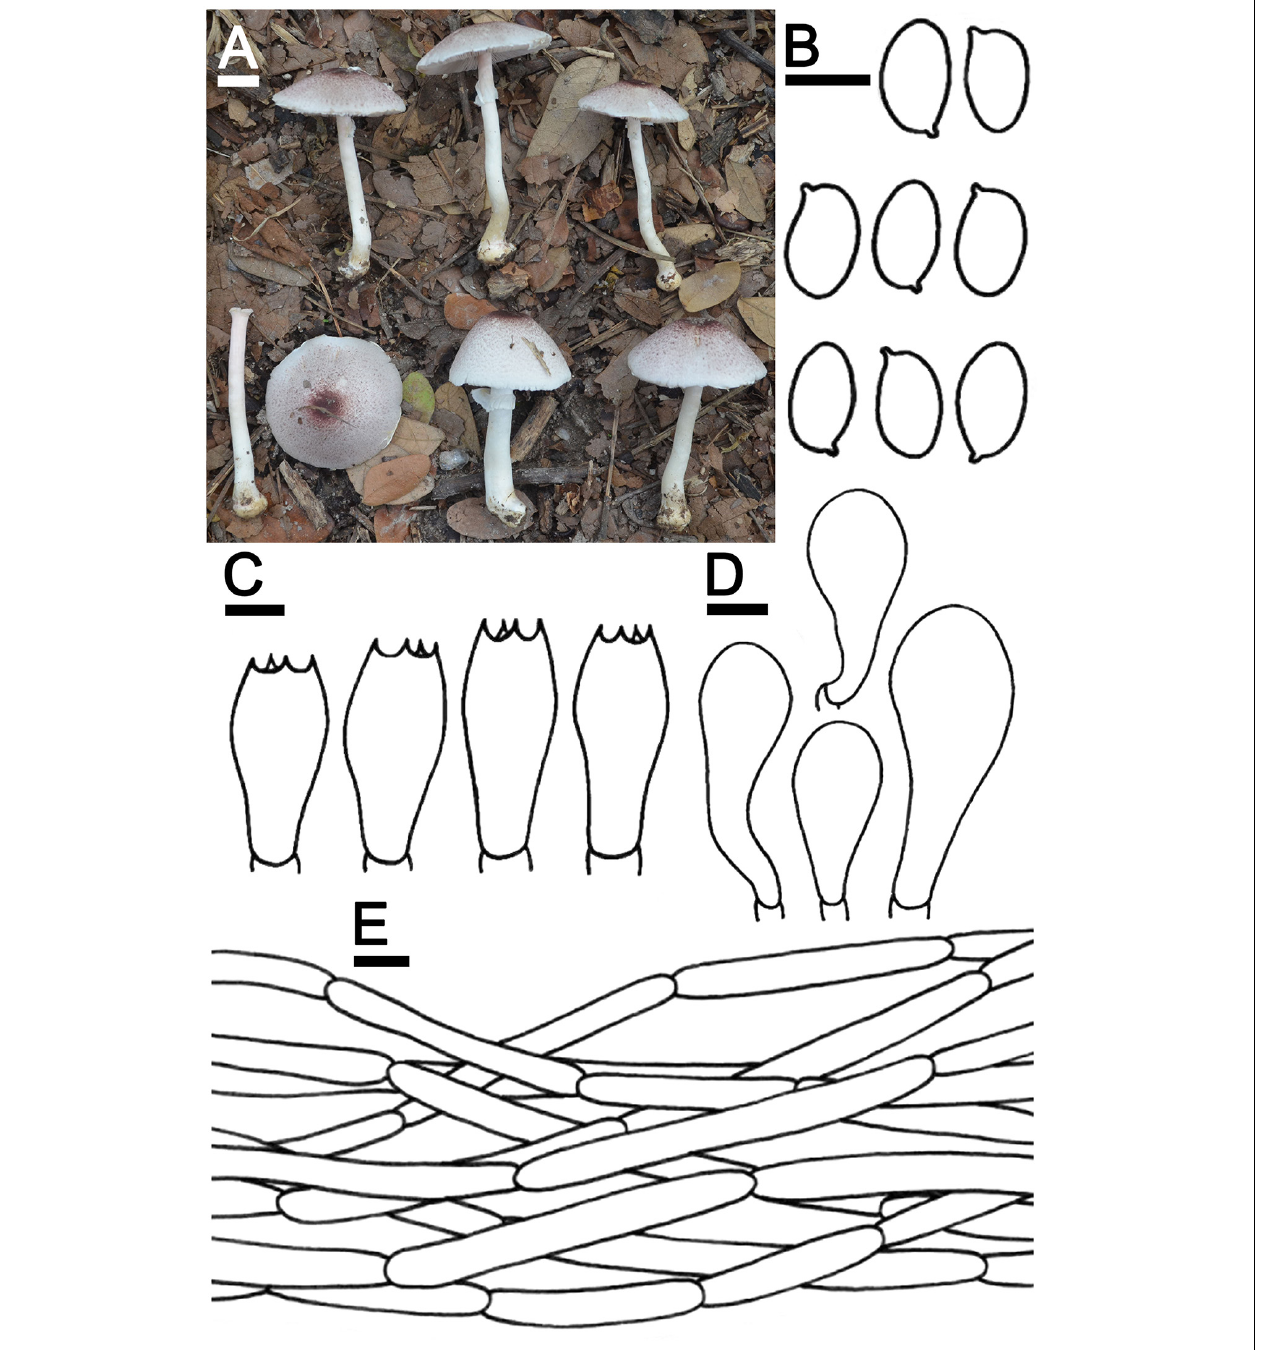
FIGURE 5 | Agaricus thailandensis SDBR-CJ0118A (holotype). (A) Basidiomata on the field, (B) Basidiospores, (C) Basidia, (D) Cheilocystidia, (E) Pileipellis. Scale bars (A) = 1 cm, (B–D) = 5 µ m, and (E) = 10 µ m.